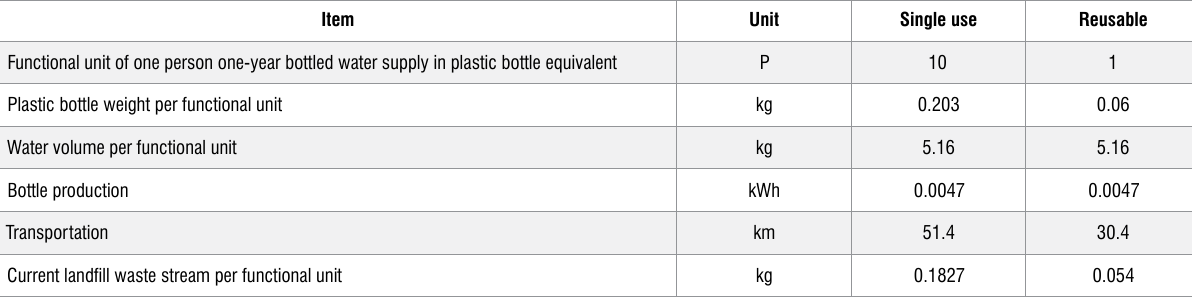
Functional unit inventory of PET bottles